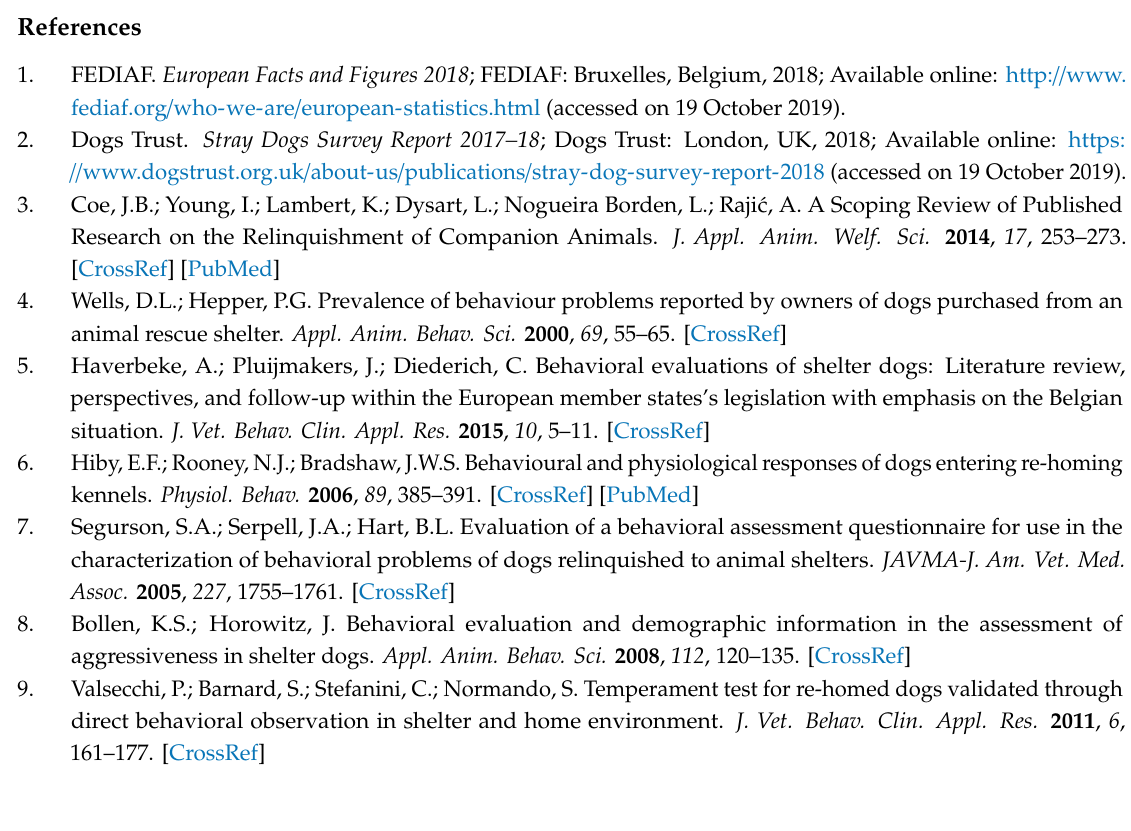
Table S1: Temperament test description and scoring system, Table S2: Ethogram used to score the behaviour of the tested dogs when presented with either a real or a fake dog opponent, Table S3: Statistical test and p -values used to investigate whether the PC scores from the dog-dog interaction test di ff ered in relation to the stimulus dogs’ size (small / large) and nature (real / fake), Figure S1: Pictures of the large and small fake dogs used for testing, Figure S2: Boxplot showing group comparisons for ( a ) the first PCA component scores ‘confidence’ and ( b ) the second PCA component scores ‘cautiousness’ ( c ) the third component scores ‘assertiveness’ and ( d ) the final component score ‘fearfulness’ in response to the di ff erent stimulus dogs’ characteristics (real vs. fake and small vs. large). Dots represent